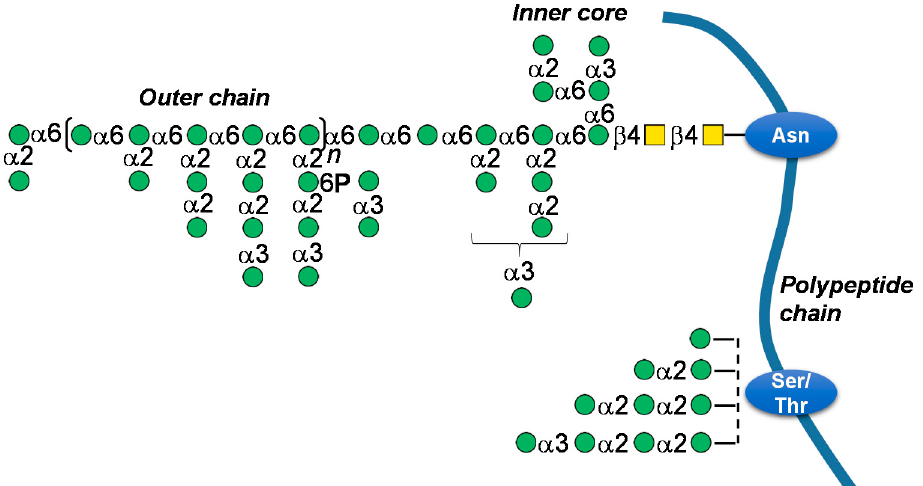
Figure 3. Some structural details of Saccharomyces cerevisiae mannan, adapted from Hernández et al. [180]. Structure was draw using the Symbol Nomenclature for Graphical Representation of Glycans, [181].